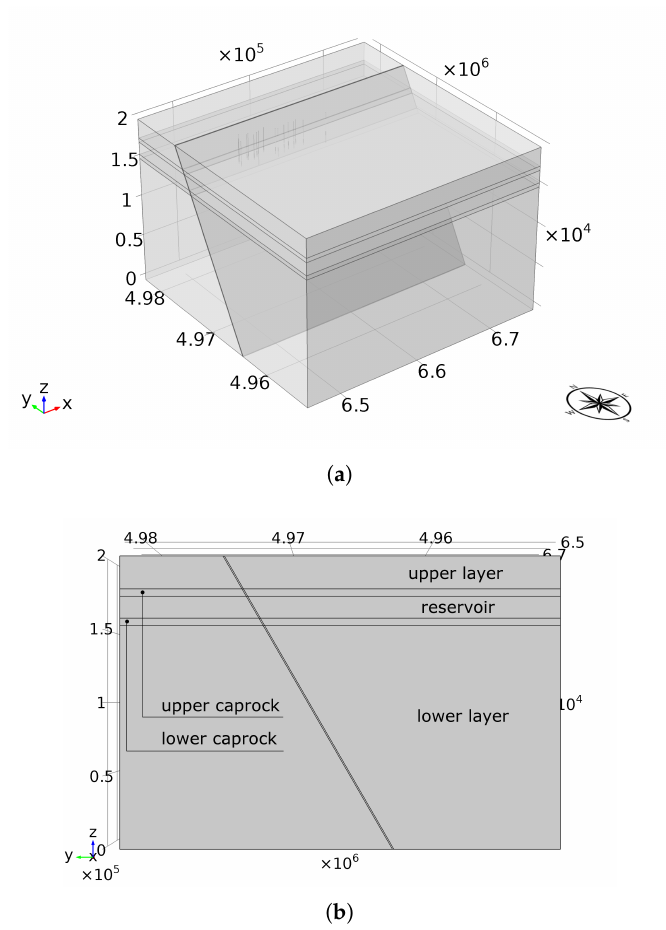
Figure 8. Mirandola emergent fault and Cavone oilfield modeling: geometry ( a ) and lateral view ( b ) of the 3D FE model; dimensions are 10 5 m in x , 10 6 m in y and 10 4 m in z